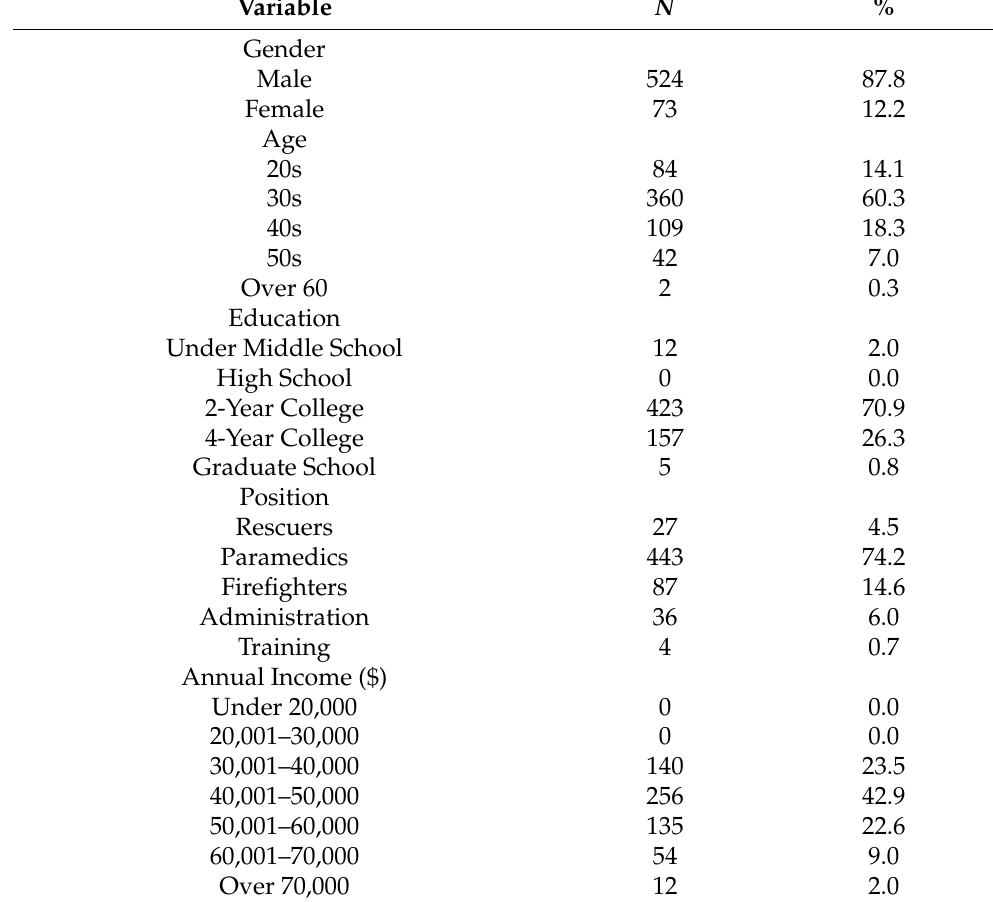
Table 2. Descriptive statistics of the sample ( N =